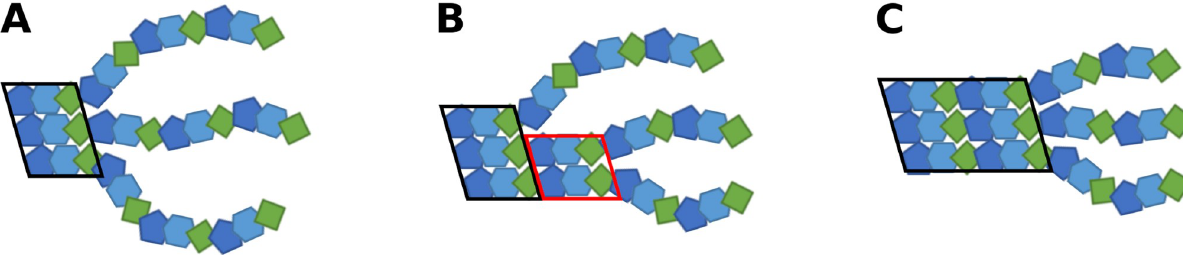
Fig 4. Schematic illustrations of the sequential folding propagation process. (A) Starting with an already folded part of the triple helix (framed by a black box in A, each residue is represented by a colored bead). (B) Followed by the formation of a near-native structure of two chains (red box in B) and subsequent folding of the third chain (framed box in C) to form an extension of the triple helix by three residues of each